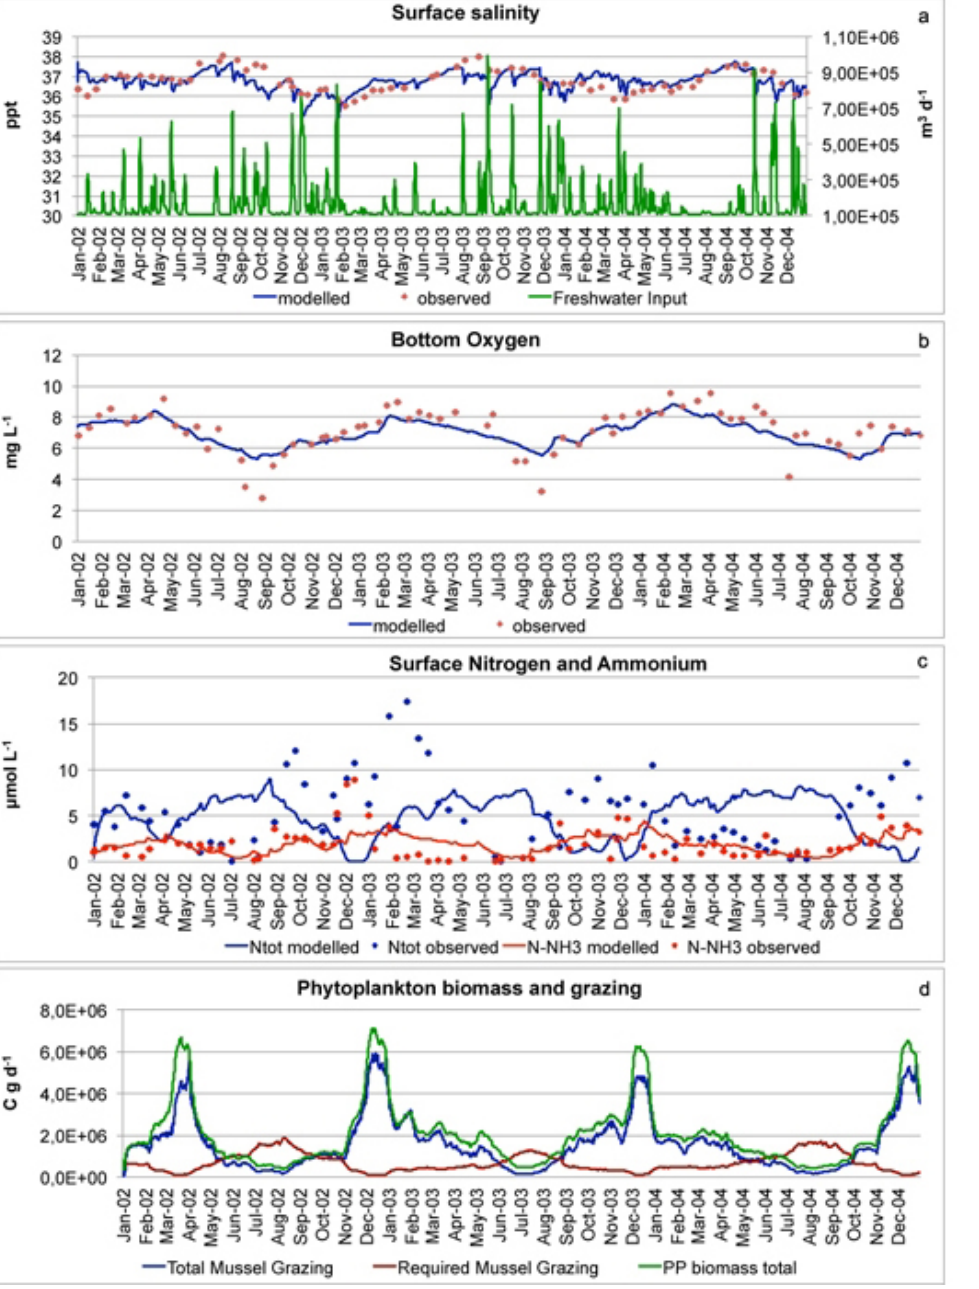
Fig. 8 . Sub-basin Seno I: Examples of modeled surface and bottom layer variables relative to the vertically average values at one central station (red dots): (a) surface salinity, (b) bottom oxygen, (c) surface nitrogen (nitrite + nitrate) and ammonium, (d) phytoplankton biomass (green) and grazing as required by the mussel submodel (red) and mussel grazing as required by the PP submodel